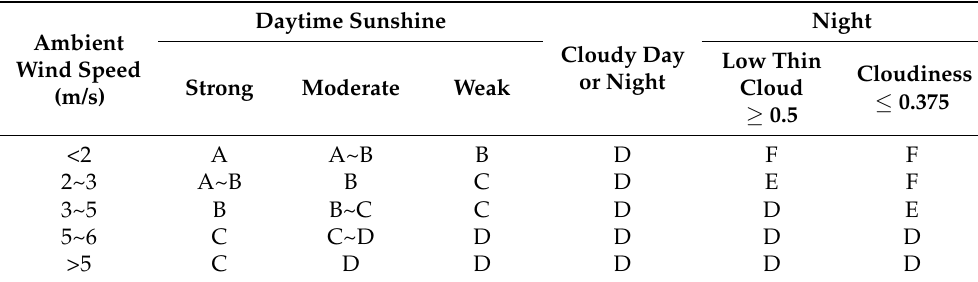
Table 2. Atmospheric stability